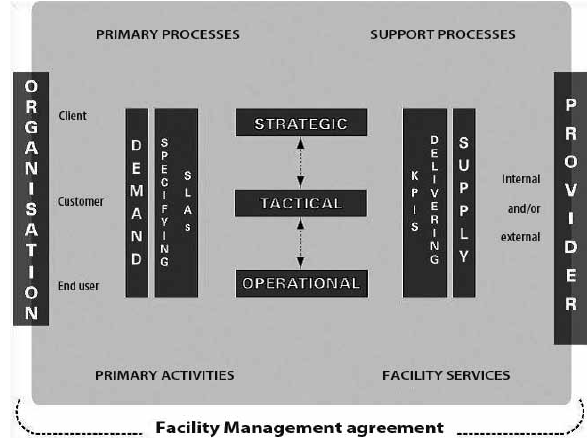
Fig. 1. European FM model adapted from EN 15221- 1:2006 Facility Management …